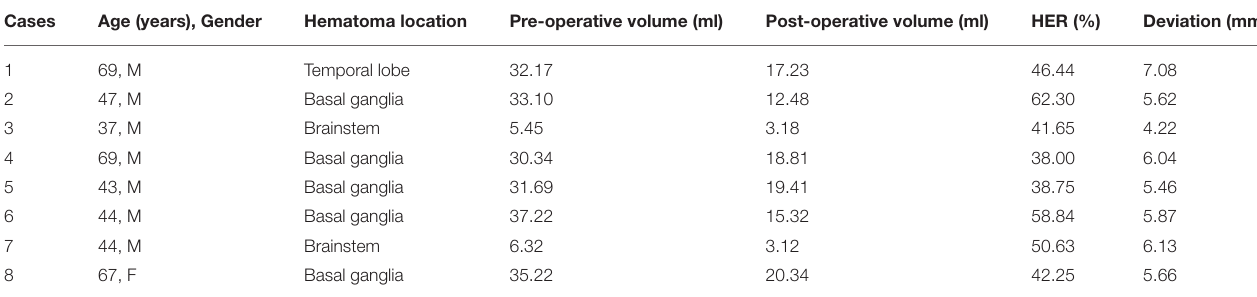
TABLE 1 | Demographic and clinical data of eight patients in the research.